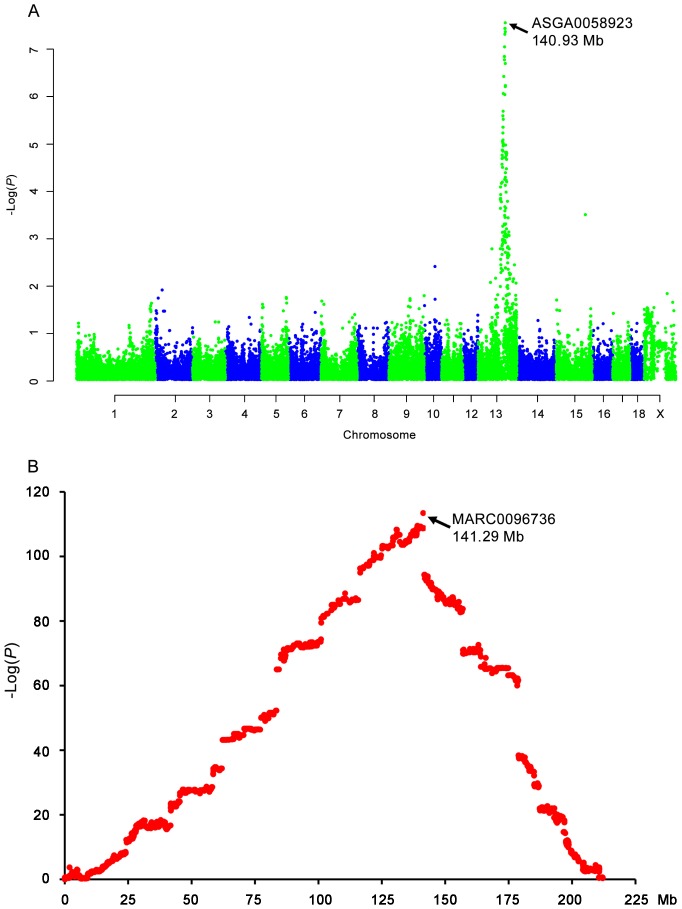
GWAS and LDLA analyses indicate MUC13 as a strong candidate of F4acR.(A) Genome-wide association mapping of the locus in the White Duroc × Erhualian F2 intercross using the 60K chips. Evidence for linkage (y axis) is measured as corrected log(1/p). The most significantly associated marker is ASGA0058923 at 140.93 Mb (Sscrofa10.2) proximal to the MUC13 gene (141.02–141.14 Mb, Sscrofa10.2) on chromosome 13. (D) Combined linkage disequilibrium and linkage analysis of the locus in the White Duroc × Erhualian F2 intercross using the 60K chips. The graph shows the linkage signal on chromosome 13. The most significant marker is MARC0096736 at 141.29 Mb (Sscrofa10.2) adjacent to the MUC13 gene.